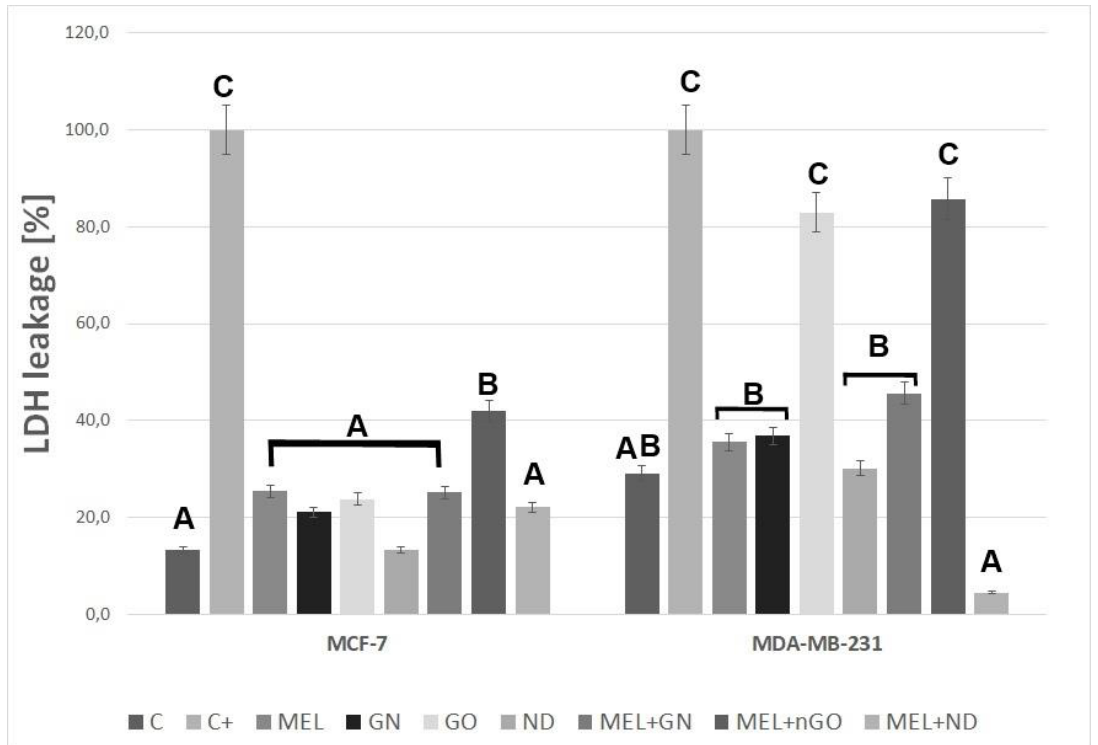
Figure 6. The integrity of MCF-7 and MDA-MB-231 cell membranes after treatment with melittin complexes with nanoparticles, melittin and nanoparticles alone. C—control group; MEL—group treated with melittin at a concentration of 10 mg/L; GN—group treated with natural graphene (20 mg/L); nGO—group treated with graphene nanoxide (20 mg/L); ND—group treated with nanodiamond (20 mg/L); GN + MEL—group treated with melittin complex (10 mg/L) and natural graphene (20 mg/L); nGO + MEL—group treated with melittin complex (10 mg/L) and graphene nanoxide (20 mg / l); ND + MEL—group treated with melittin complex (10 mg/L) and nanodiamond (20 mg/L). A, B, C—results in one group with different indexes are significantly different ( p -value < 0.005).